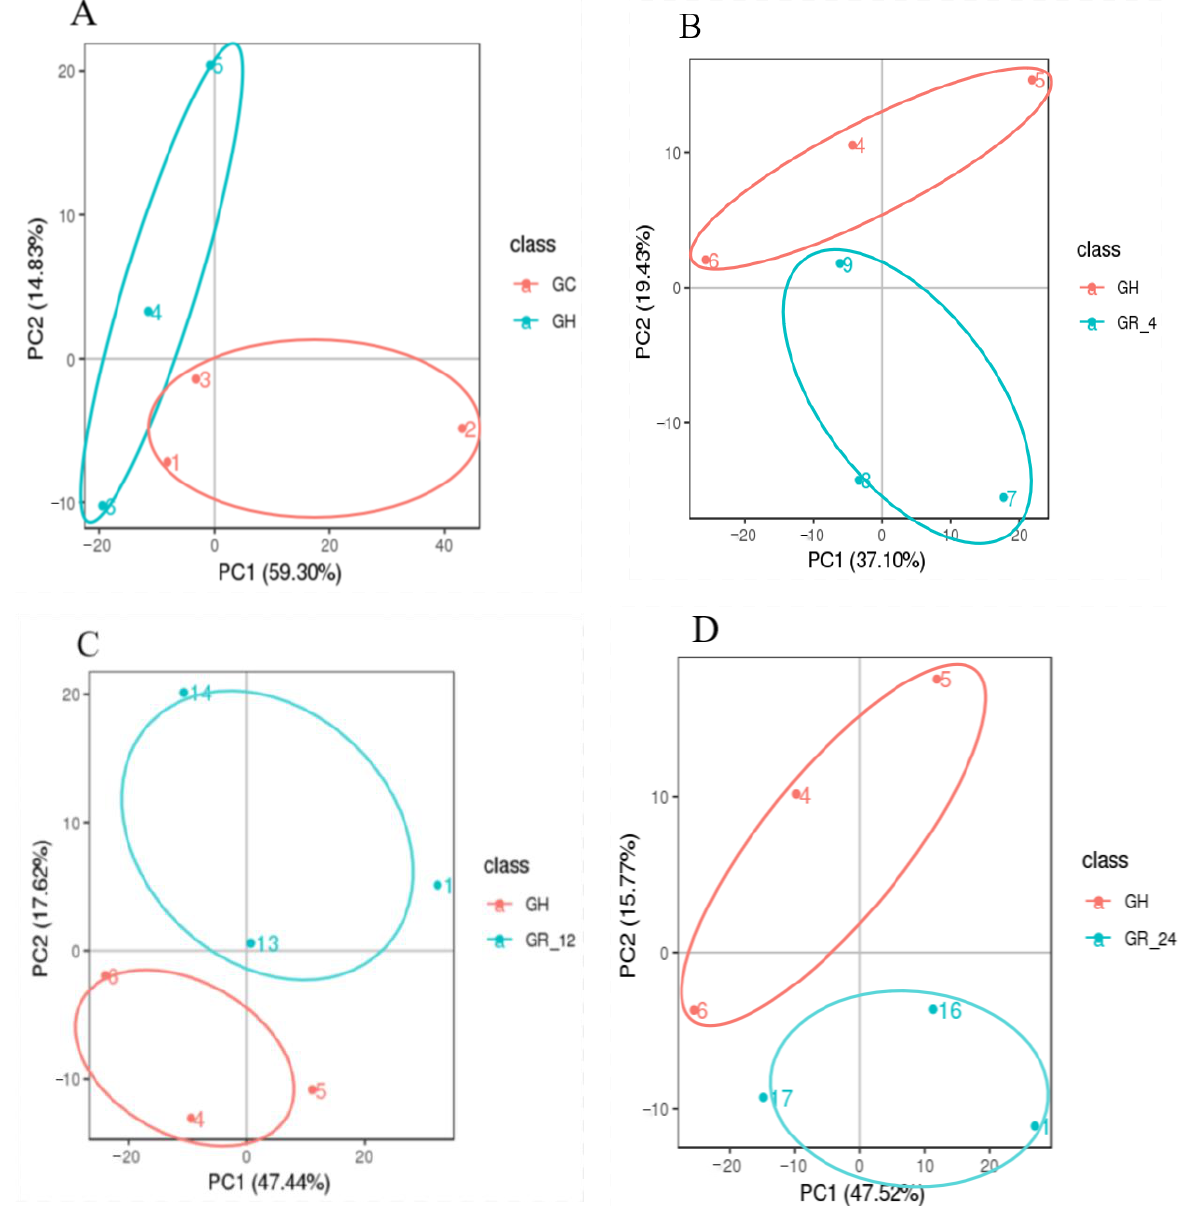
Figure 1. The principal component analysis (PCA) plots of the metabolomic data. ( A ) Groups GH and GC, ( B ) groups GH and GR_4, ( C ) groups GH and GR_12; ( D ) groups GH and GR_24. Each point represents one replicate pooled gill sample, the different numbers represent sample numbers.